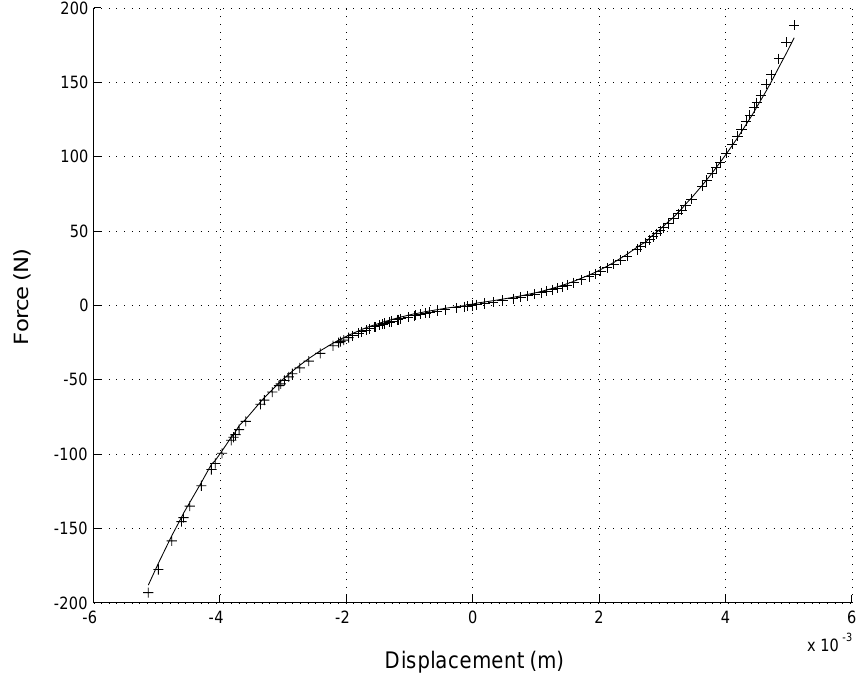
Fig. 12. Linear modal analysis of HP turbine blade with friction damping non-linearity: ... True linear parameters, Pseudo linear